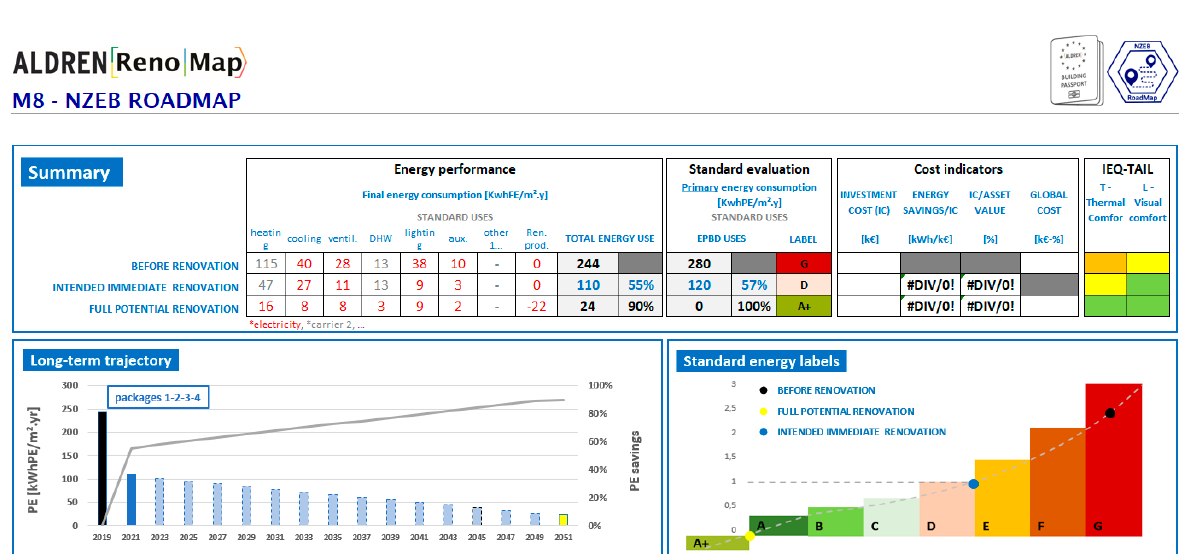
Table 5. Summary of the ALDREN RenoMap protocol tasks. #